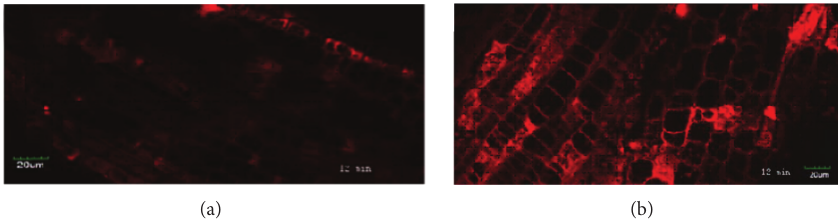
Figure 4: Vesicles in the transgenic plant and WT rice. (a) Vesicle morphology in the wild-type rice root tip. (b) Vesicle morphology in the transgenic plant root tip. The root tips were incubated in 5 𝜇 g/mL FM4-64 (Sigma) for 12 min, and images of the vesicles were captured using confocal microscopy. Bar, 20 𝜇